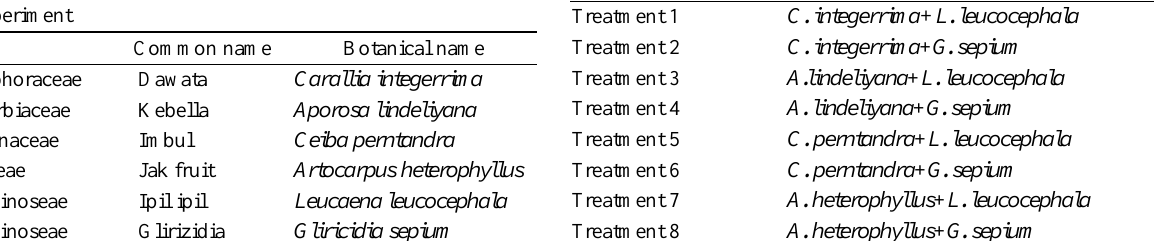
Table 2. Treatment combinations of high tannin non-legume and low tannin legumes used for the experiment